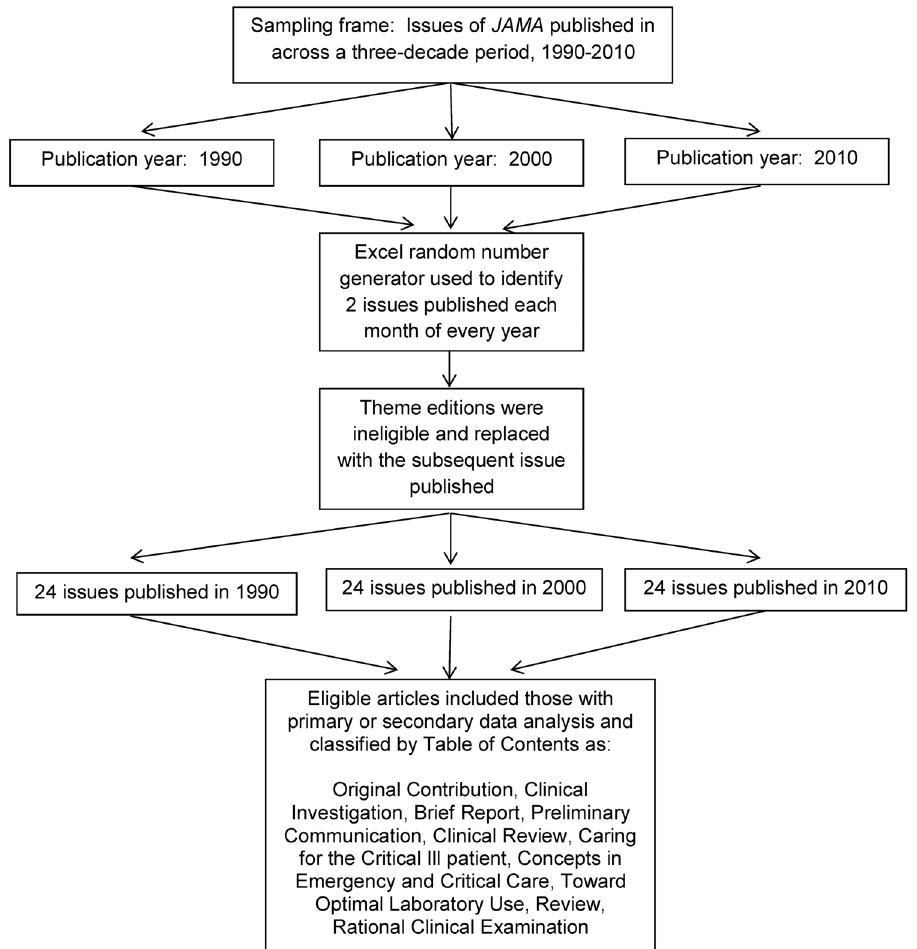
Figure 1. Flow chart outlining selection criteria of articles for content analysis.